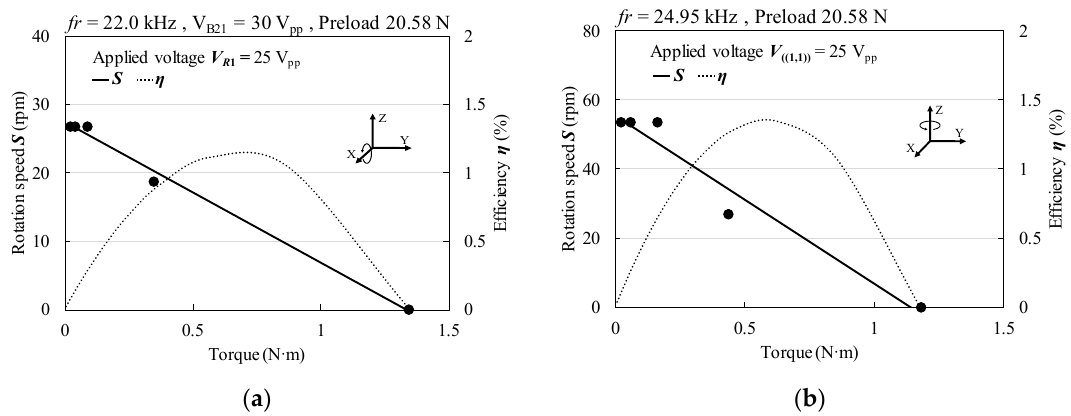
Figure 19. Load characteristics with preload of 20.58 N. ( a ) Rotation around X(Y)-axis, and ( b ) Rotation around Z-axis.